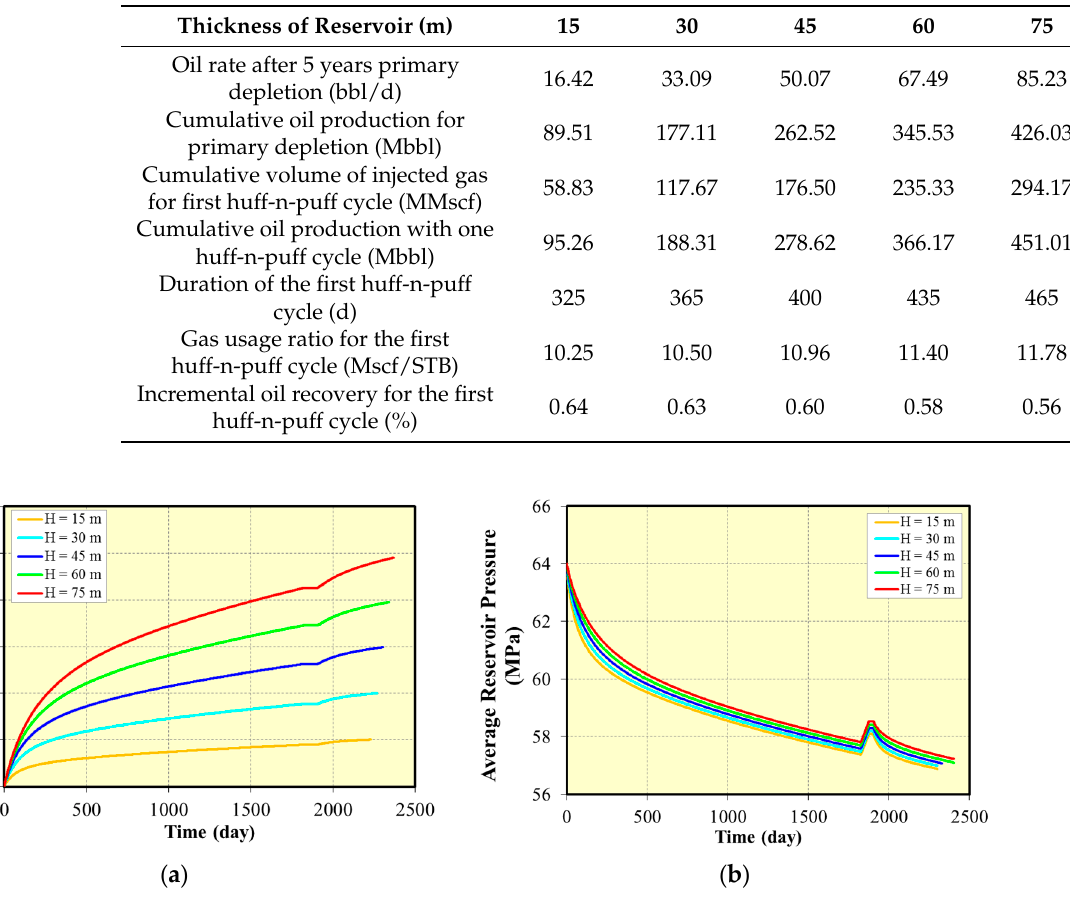
Figure 5. Correlation between reservoir thickness and huff-n-puff results: ( a ) Cumulative oil production and incremental oil recovery for different reservoir thickness; ( b ) Duration of the first huff-n-puff cycle and gas usage ratio for different reservoir thickness.